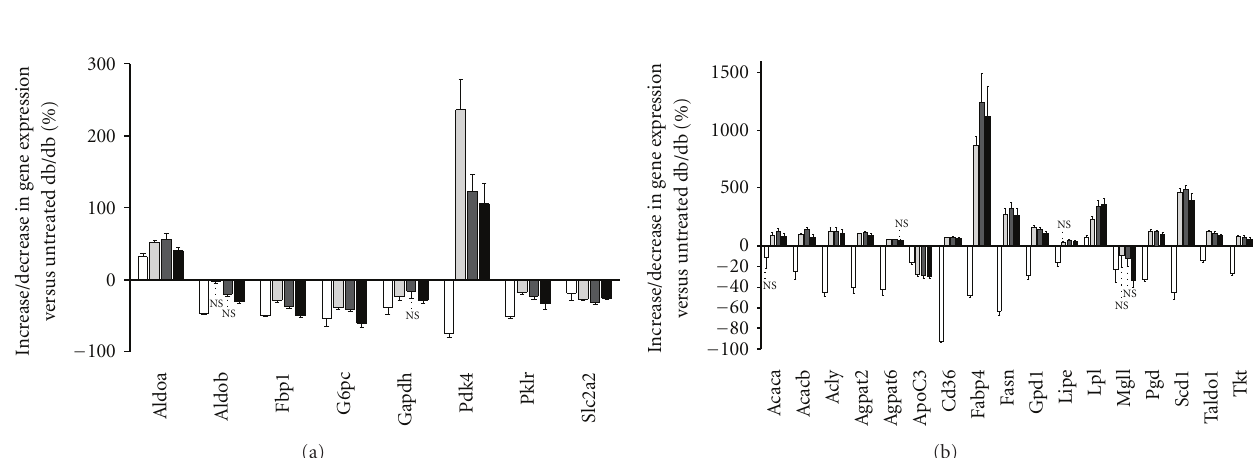
Figure 1: Expression profiles of key genes involved in liver glucose and lipid metabolism. Di ff erentially expressed genes in db/+ (the white square) as well as 10 (the o ff -white square), 30 (the grey square), and 100 (the black square) mg/kg RSG-treated db/db mice were measured versus untreated db/db and plotted as the mean (% increase/decrease of db/db control) ± SEM ( n = 6). NS; P ≥ . 001 otherwise P < . 001. (a) Genes related to glucose metabolism: Aldoa, Aldob, aldolase 1A, 2B; Fbp1, fructose bisphosphatase 1; G6pc, glucose-6-phosphatase, catalytic; Gapdh, glyceraldehyde-3-phosphate dehydrogenase; Pdk4, pyruvate dehydrogenase kinase, isoenzyme 4; Pklr, pyruvate kinase liver and red